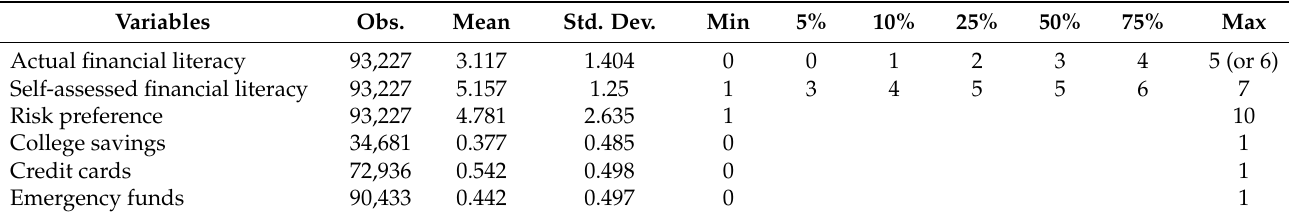
Table 1. Summary statistics of key variables.